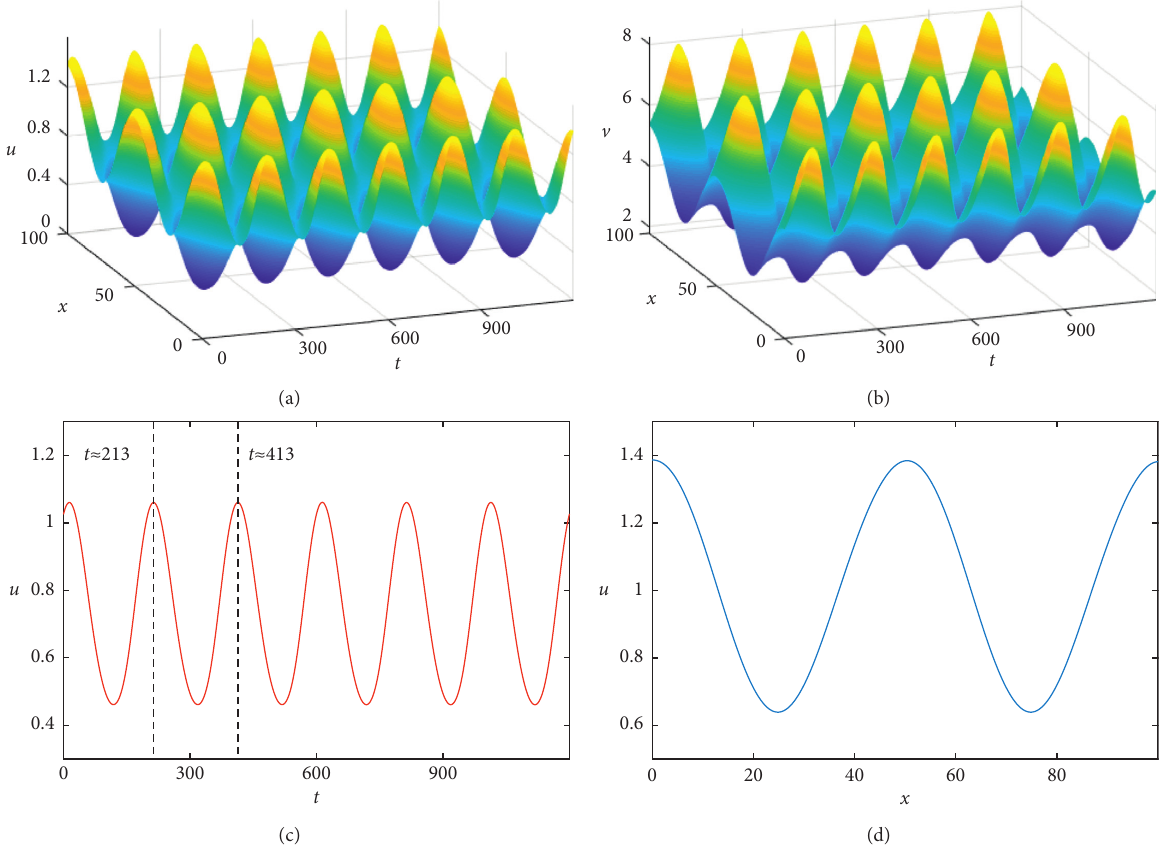
Figure 4: Numerical solutions of system (6a)–(6c): (a) prey population u , (b) predator population v , (c) profile of u ( t ) at x � 50, and (d) profile of u ( x ) at t � 1200. Here, r ( t,x ) � 1 . 2 + 0 . 1sin ( π ∗ t /100 )+ 0 . 01cos ( 4 ∗ π ∗ x /100 ) ∗ sin ( 4 ∗ π ∗ x /100 ) , K ( t,x ) � 2 +